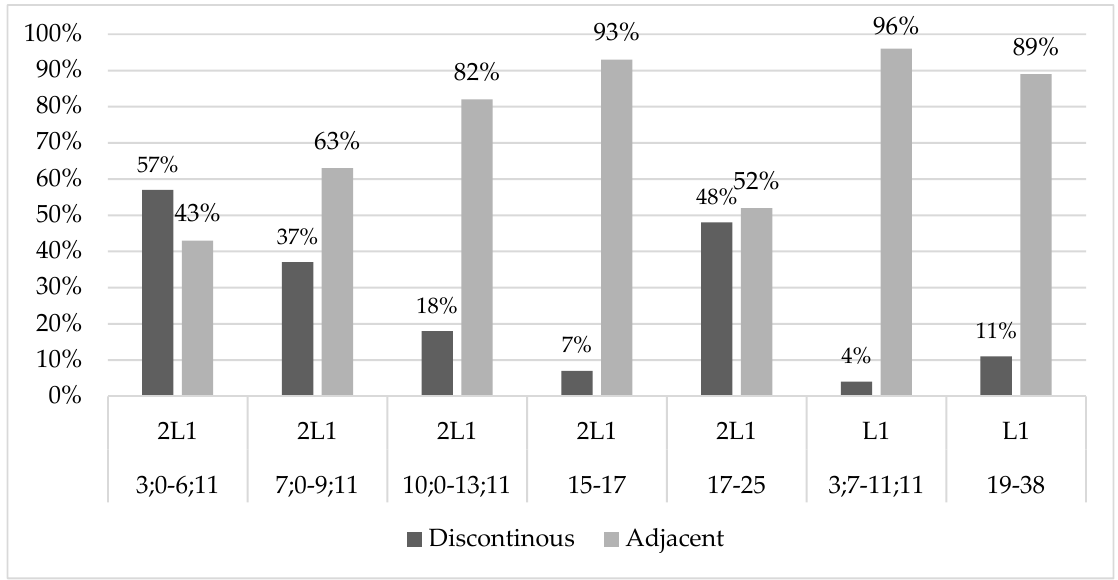
Figure 2. Relative frequency of discontinuous vs. adjacent word order pattern in verb phrases with noun phrases (NPs) in simultaneous bilinguals (2L1) and monolinguals (L1).